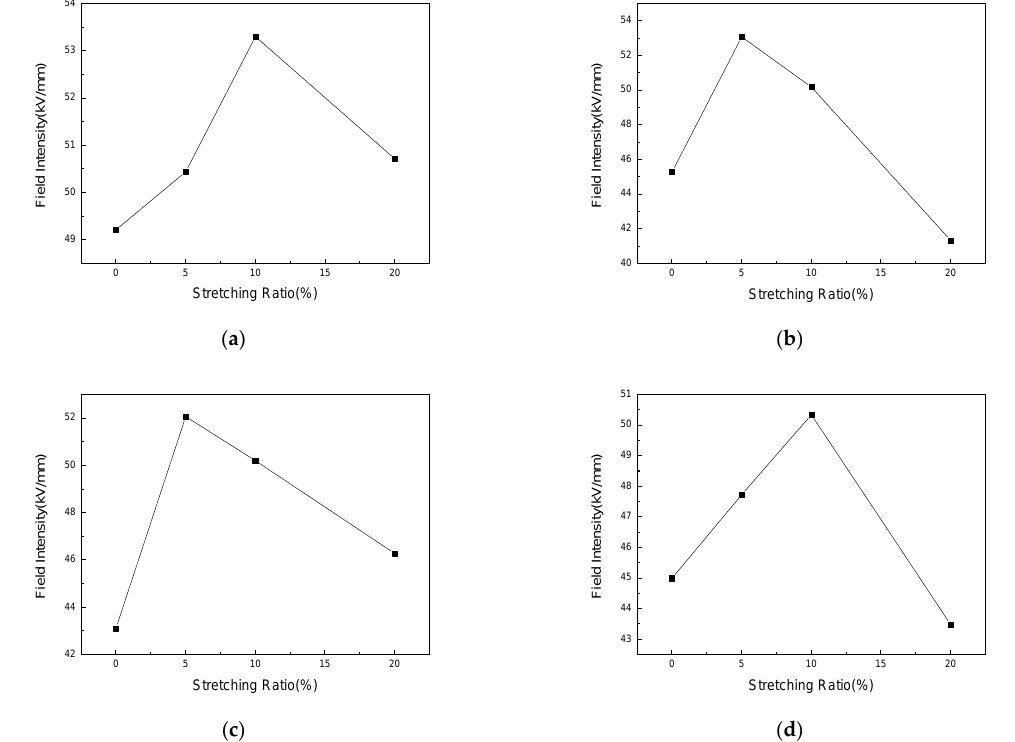
Figure 10. Relationship between maximum electric field and stretching ratio difference in each sample with average stress 40 kV/mm. ( a ) Sample 1; ( b ) Sample 2; ( c ) Sample 3; ( d ) Sample 4. 5. Depolarized Space Charge Characteristics of Composites After half an hour with 40 kV/mm electric field, the external electric field was re- moved, and the samples were short-circuited to observe their depolarization space charge distribution. The results are shown in Figure 11. It is worth noting that the limitation of